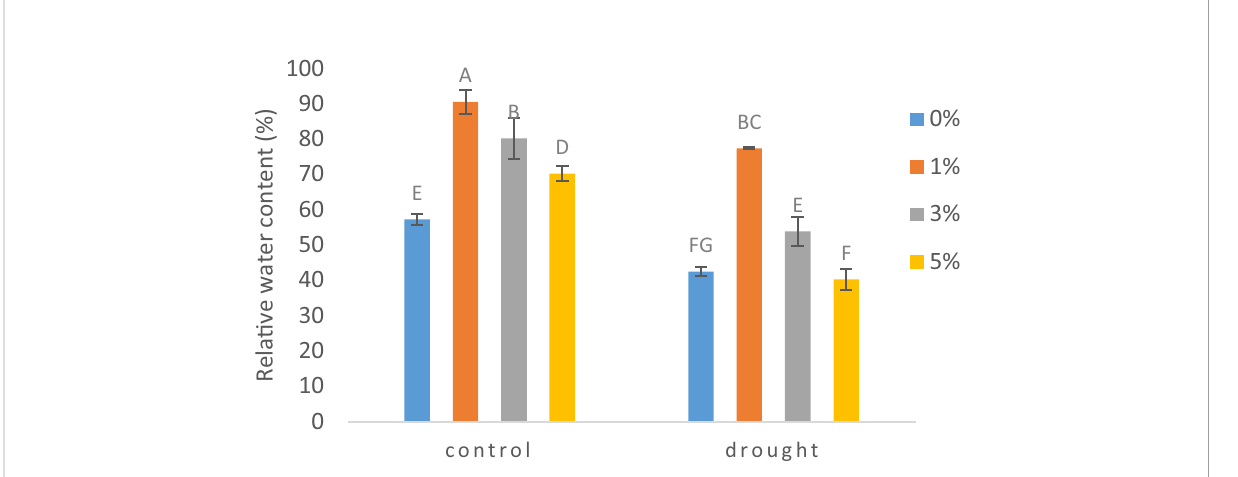
FIGURE 1 The effect of different concentrations of foliar application of nano-nutrients solution on relative water content of leaves of tomato (Solanum lycopersicum) under drought. Mean values are the average of three replicates. The upper case alphabetic letters indicate signi fi cant differences (P ≤ 0.05) among treatments using Tukey's test.